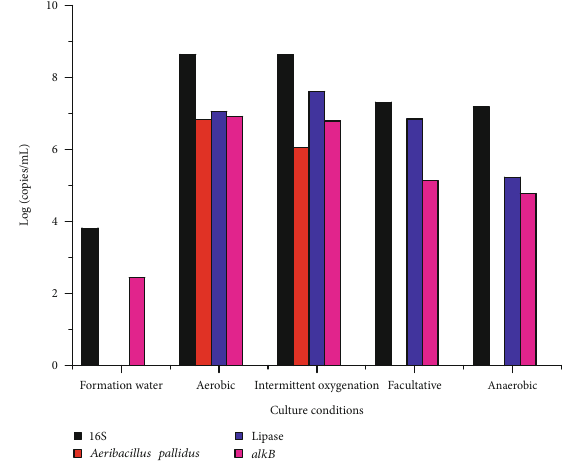
Figure 4: Abundance of emulsifying bacteria in di ff erent